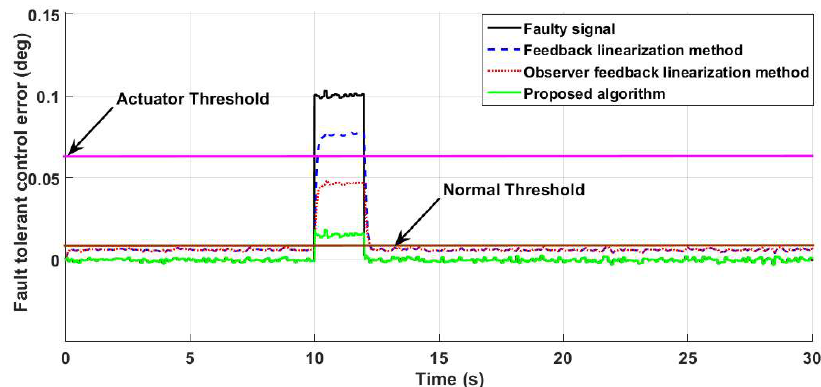
17 of 26 Table 4. Fuzzy rule table for online tuning of the proposed fault-tolerant control algorithm. Error (e)